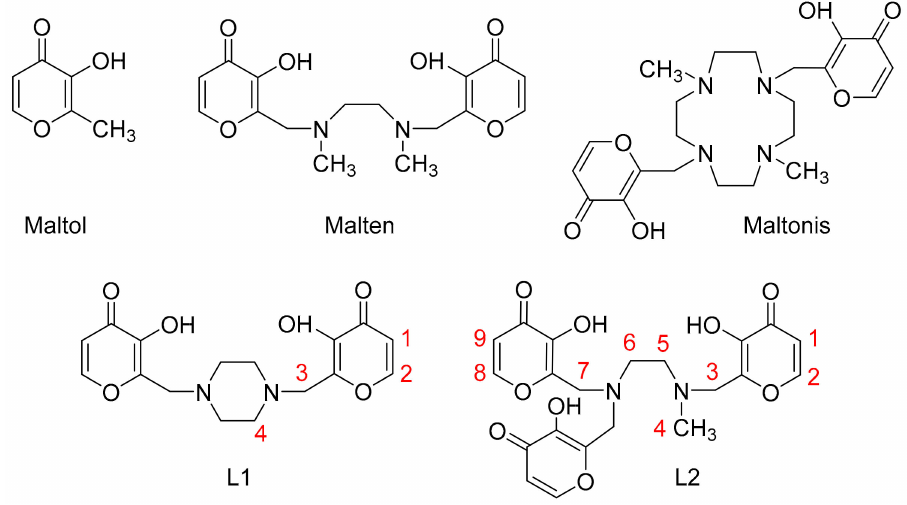
Figure 1. Compounds maltol, malten, maltonis, L1 and L2 with atom labelling used in NMR